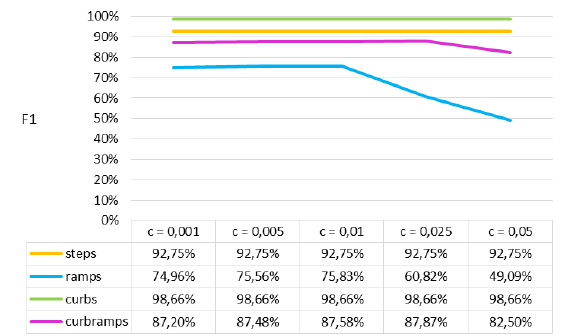
Figure 13. Relation between F1 index and c value